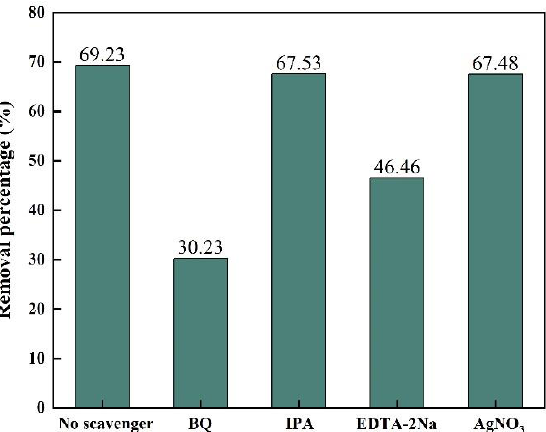
Figure 8. Trapping experiments of active species during photocatalytic degradation on Cu/BVO.